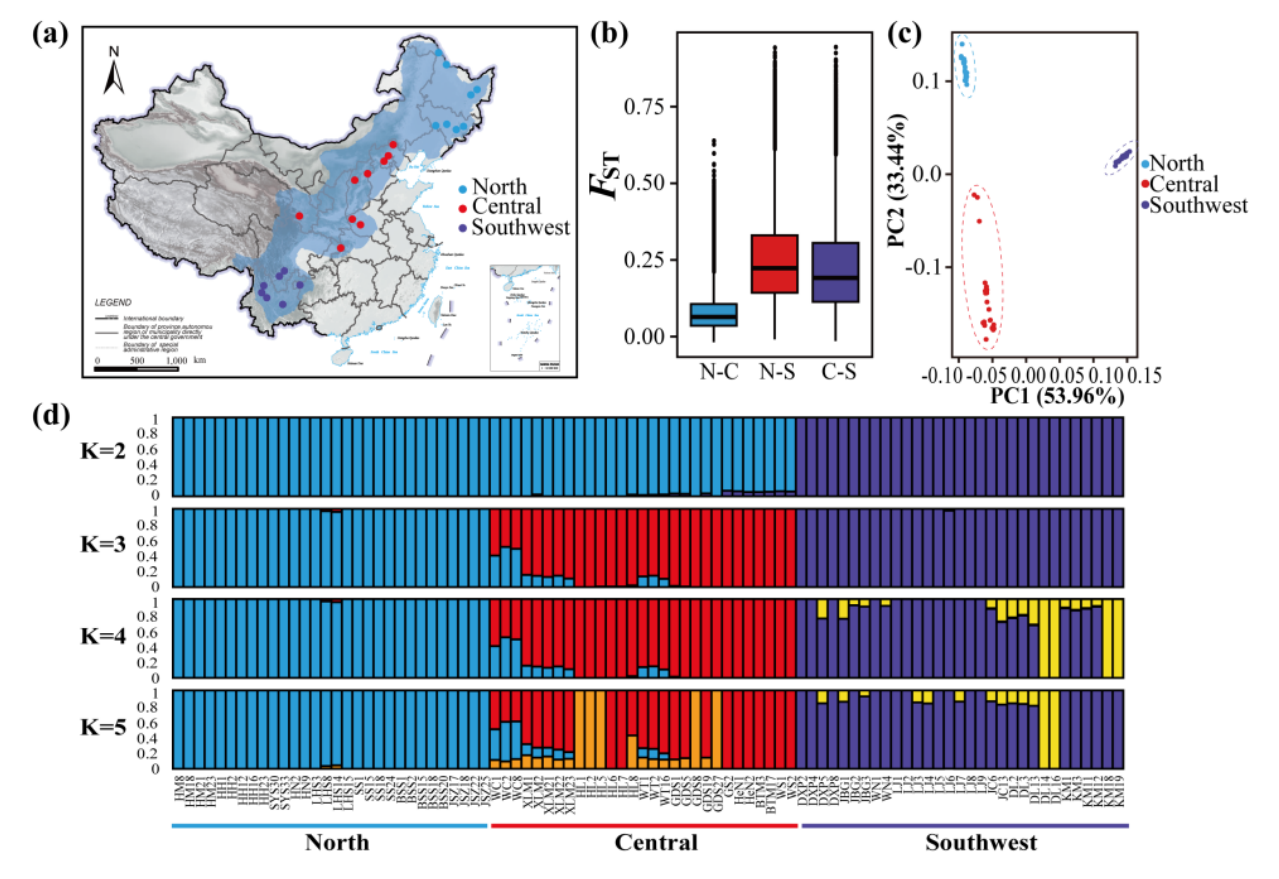
Figure 1. Sample collection, relative divergence measures ( F ST ), and population structure analysis of 90 P. davidiana . ( a ) Blue shadow represents the range extent of P. davidiana , 30 northern individuals (blue) were collected in Heilongjiang and Jilin of China, 29 central individuals (red) were collected in Hebei, Beijing, Shanxi, Gansu, Henan, and Chongqing, and 31 southwestern individuals (purple) were collected in Sichuan, Guizhou, and Yunnan (Yunnan–Guizhou Plateau). ( b ) Comparison of relative divergence measures ( F ST ) between north and central populations (N − C), between north and southwest populations (N − S), and between central and southwest populations (C − S). ( c ) Results from a PCA on the genetic covariance matrix for all individuals of northern individuals (blue circles) of P. davidiana , central individuals (red circles), and southwestern individuals (purple circles). ( d ) Population genetic structure in the samples based on an analysis using NGSadmix in ANGSD based on genotype